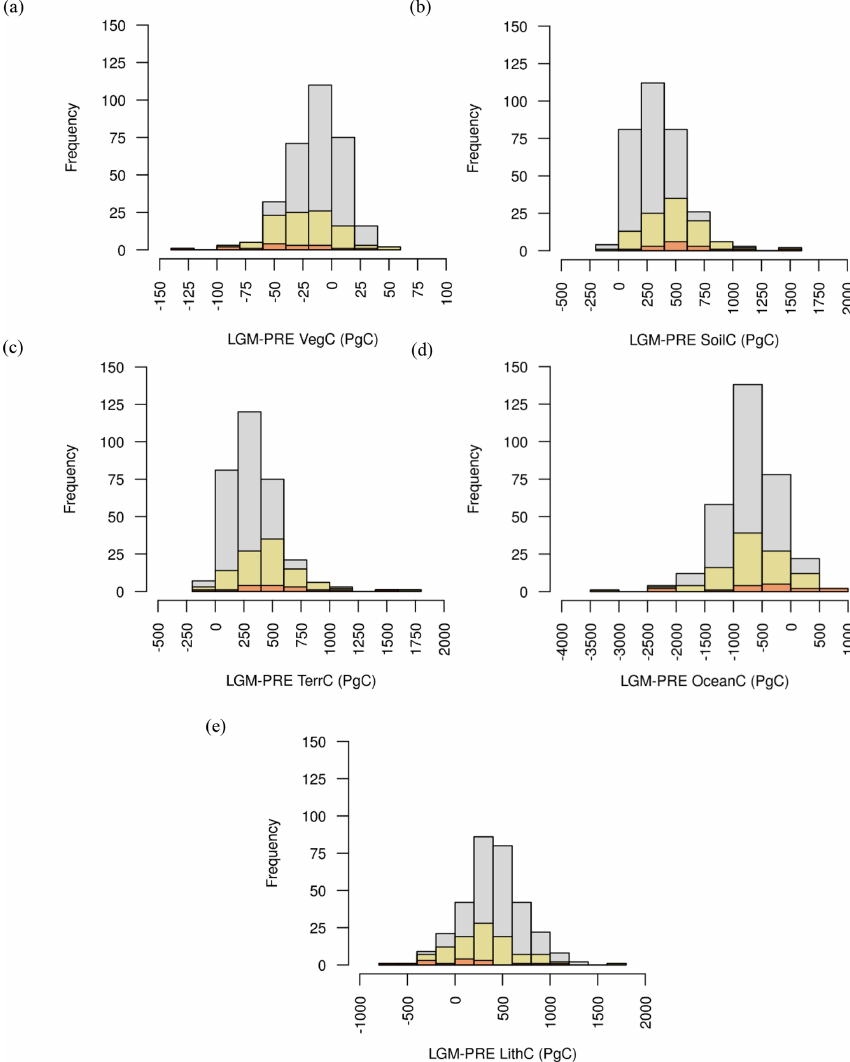
Figure 10. LGM change in vegetation (a) , soil (b) , terrestrial (vegetation plus soil) (c) , ocean (d) and lithospheric (e) carbon inventory